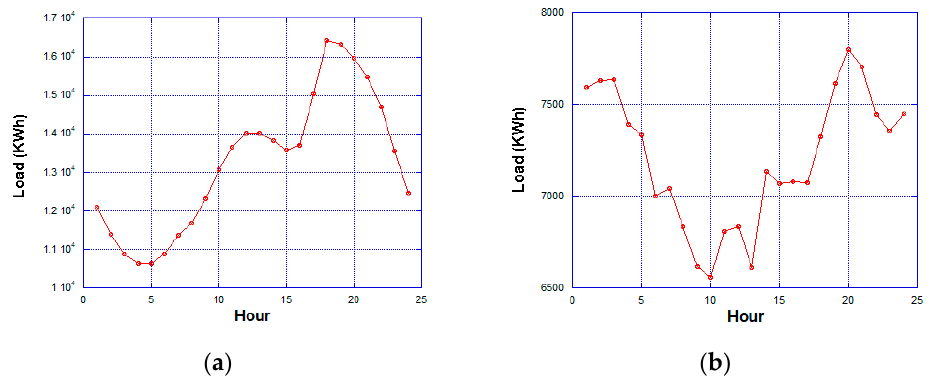
Figure 2. Example of one-day load demand of each dataset ( a ) ISO-NE dataset; ( b ) ENTSO-E dataset.